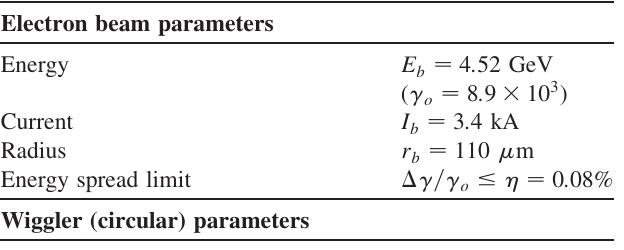
TABLE II. Parameters for LCLS FEL. Note that the actual LCLS wiggler is linearly polarized with a